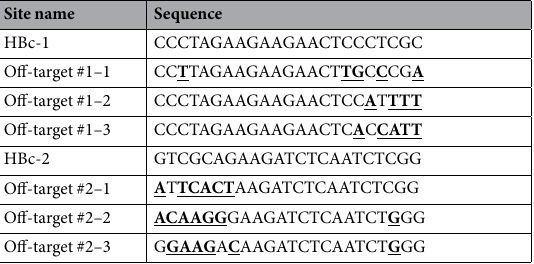
Table 1. The target HBV sequences and the possible off-target sequences in the host genome. Underlining indicates the difference between the targeted HBV sequences and the candidate off-target